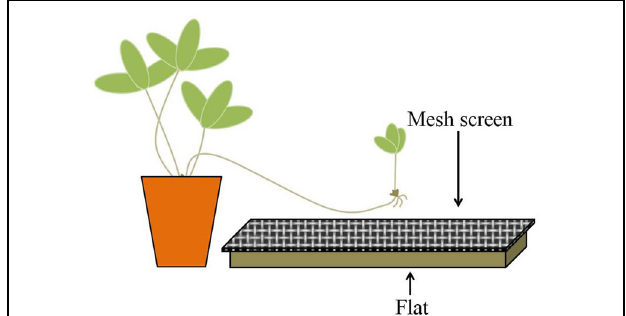
FIGURE 2 | Experimental scheme. Strawberry daughter ramets were allowed to grow over flats filled with non-sterilized (live) or sterilized (dead) substrates. Mesh screens were placed on top of the flats, approximately two centimeters above the substrate, to prevent contact between the developing ramet and the